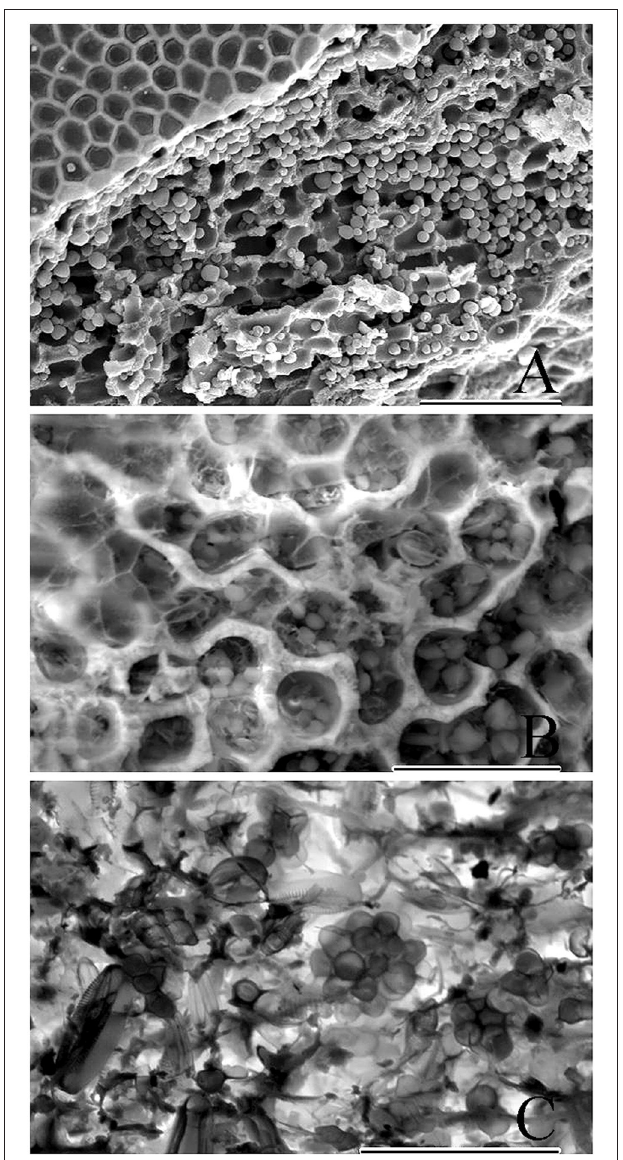
FIGURE 7 | Cryo-SEM micrographs showing copious amounts of endolithic cells . (A) Epithallus (at left) of a biogenic rhodolith, and clusters of endolithic cells viewed following sublimation and gold-coating. Scale bar = 100 µ m. (B) Exposed perithalial cells enclosing endolithic cells. Micrograph produced using backscatter electrons collected with the detector mode set to topographic. Scale bar = 30 µ m. (C) Micrograph showing clusters of endolithic cells, produced using backscatter electrons with the detector set to composition mode. Scale bar = 30 µ